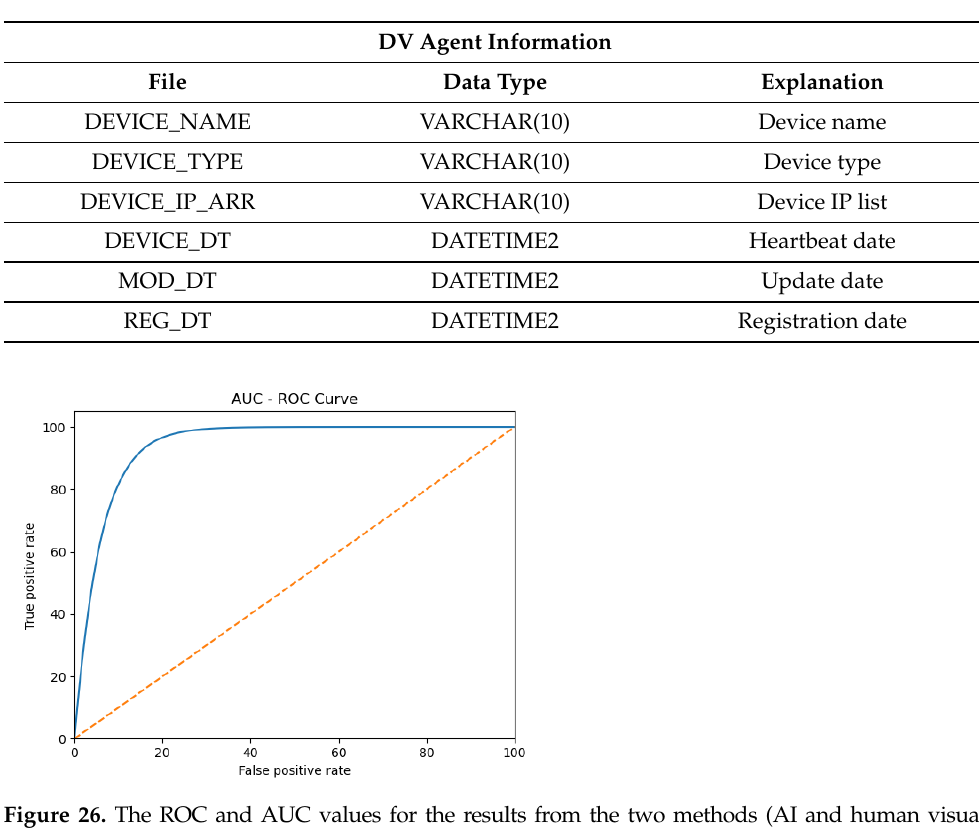
Figure 25. The structure of the facility log file transmission and management system. Table 2. The structure of the database.